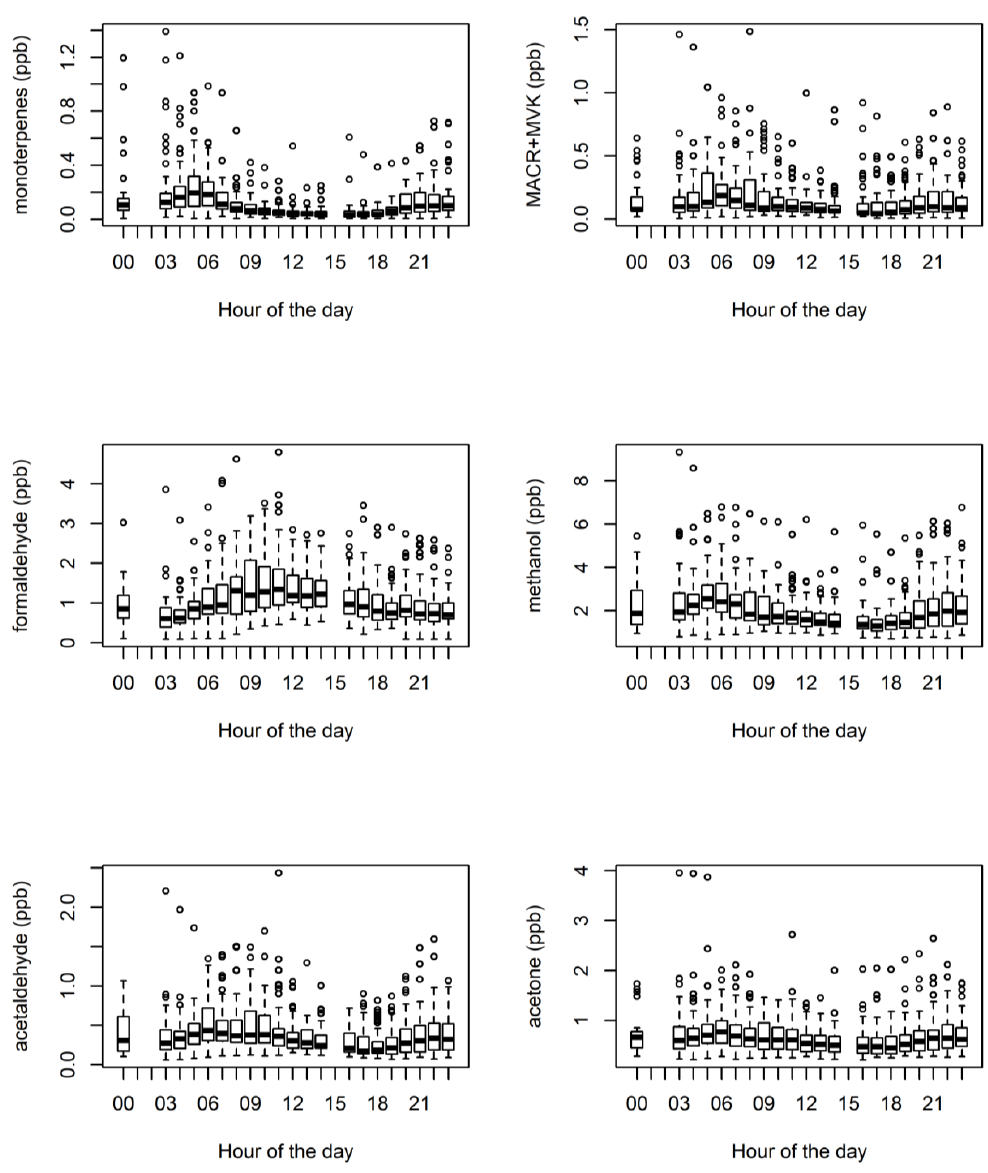
Figure A3. Composite diel cycle for monoterpenes, the sum of methacrolein and methyl vinyl ketone (MACR + MVK), formaldehyde, methanol, acetaldehyde and acetone, built of box and whisker plots showing the variability in observed mole fractions for each hour of the day. The thick black line is the median mole fraction observed, the box covers the 1st to the 3rd quantile, the whiskers are 1.7 times the interquantile range (IQR) and the dots represent values that fall outside of 1.7*IQR. Note that the two extreme heat days (8 and 18 January 2013) are excluded from the data in this plot.